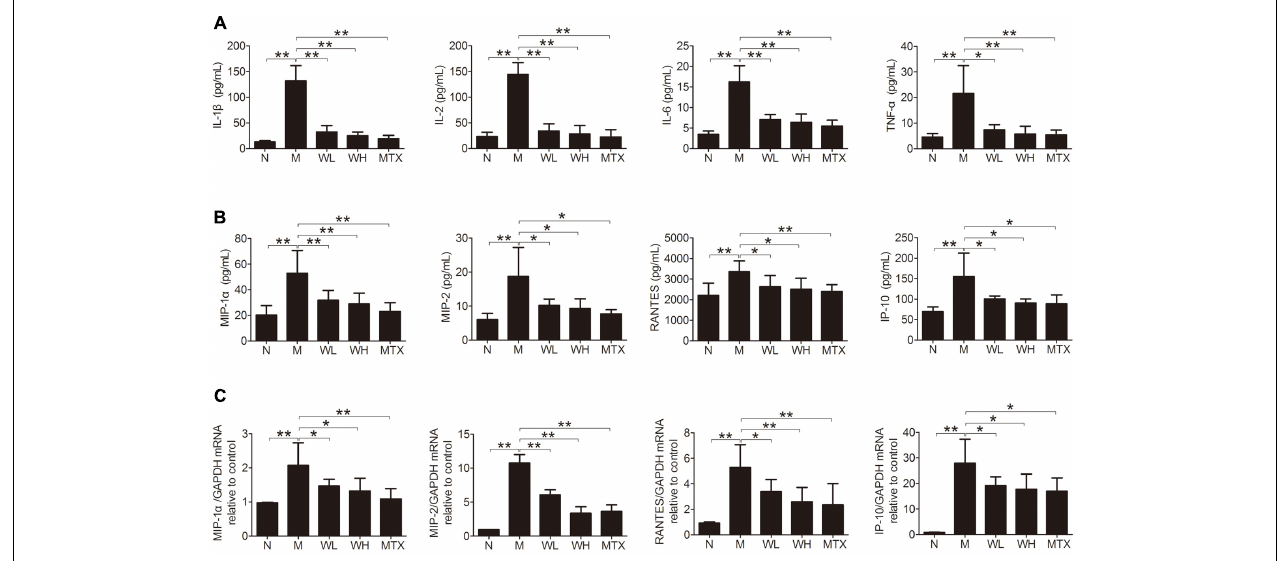
FIGURE 6 | Effects of WTD on production of cytokines and chemokines in CIA rats. (A) Effect of WTD on production of cytokines. The levels of IL-1 β , IL-2, IL-6, and TNF- α in serum of rats were determined by ELISA. (B) Effect of WTD on production of chemokines. Levels of MIP-1 α , MIP-2, RANTES, and IP-10 in serum of rats were determined by ELISA. (C) Effect of WTD on mRNA levels of chemokines. The mRNA levels of MIP-1 α , MIP-2, RANTES, and IP-10 in rats’ ankle joints were detected by real-time PCR. ∗ P < 0.05, ∗∗ P < 0.01.